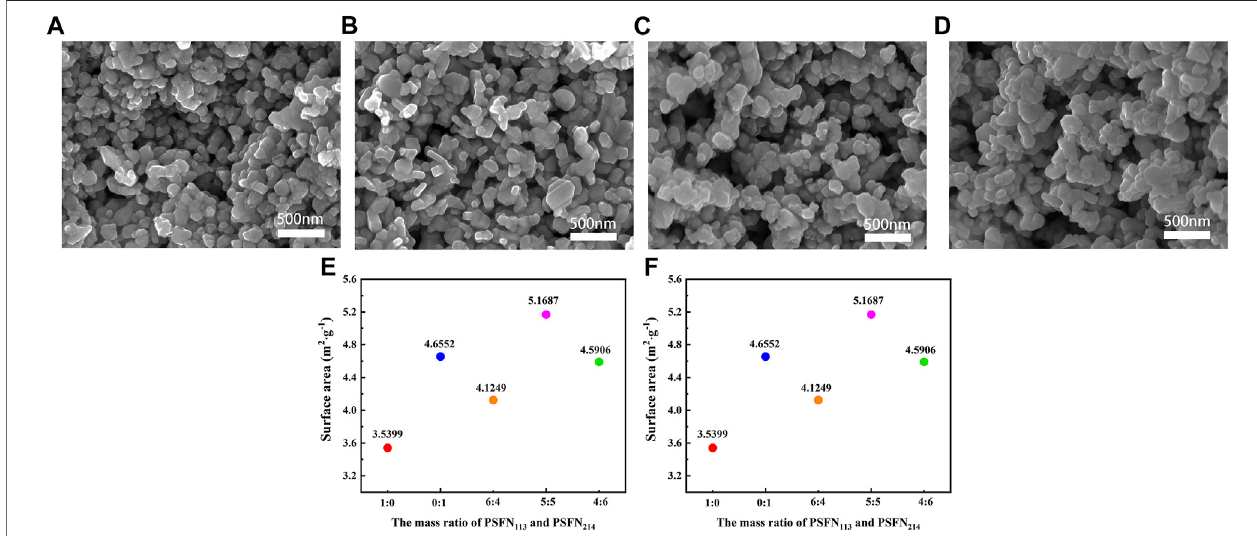
FIGURE 3 | FE-SEM images of (A) PSFN 113 , (B) PSNF 214 , (C) PSFN 113-214 (6:4), (D) PSFN 113-214 (5:5), and (E) PSFN 113-214 (4:6) cathode microstructure. (F) Speci fi c surface area of all samples.